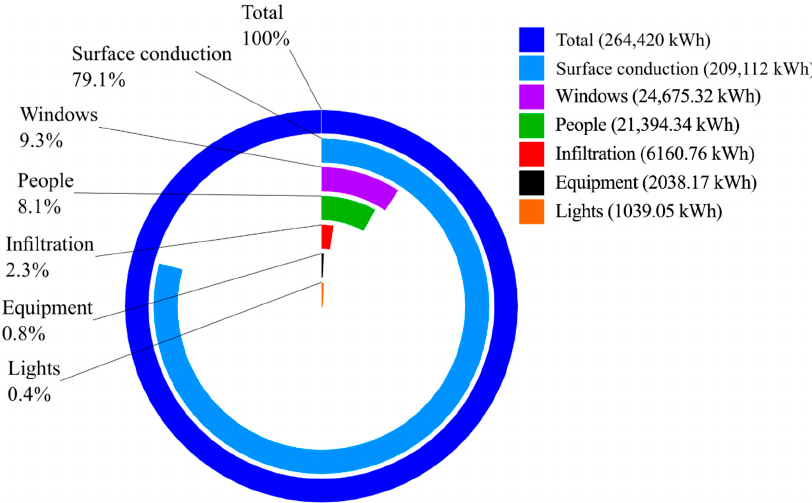
Figure 13. Annual energy nexus–sensible heat gains from different sources in the building. Annual greenhouse gas (CO 2 ) emissions from the seven AC configurations is presented in Figure 14.